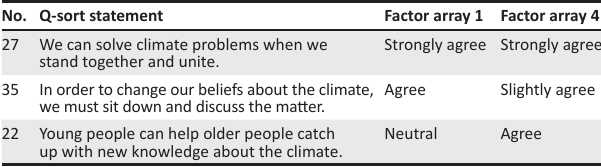
TABLE 2: Factor arrays of Q-sort statements related to Afro-polychronic